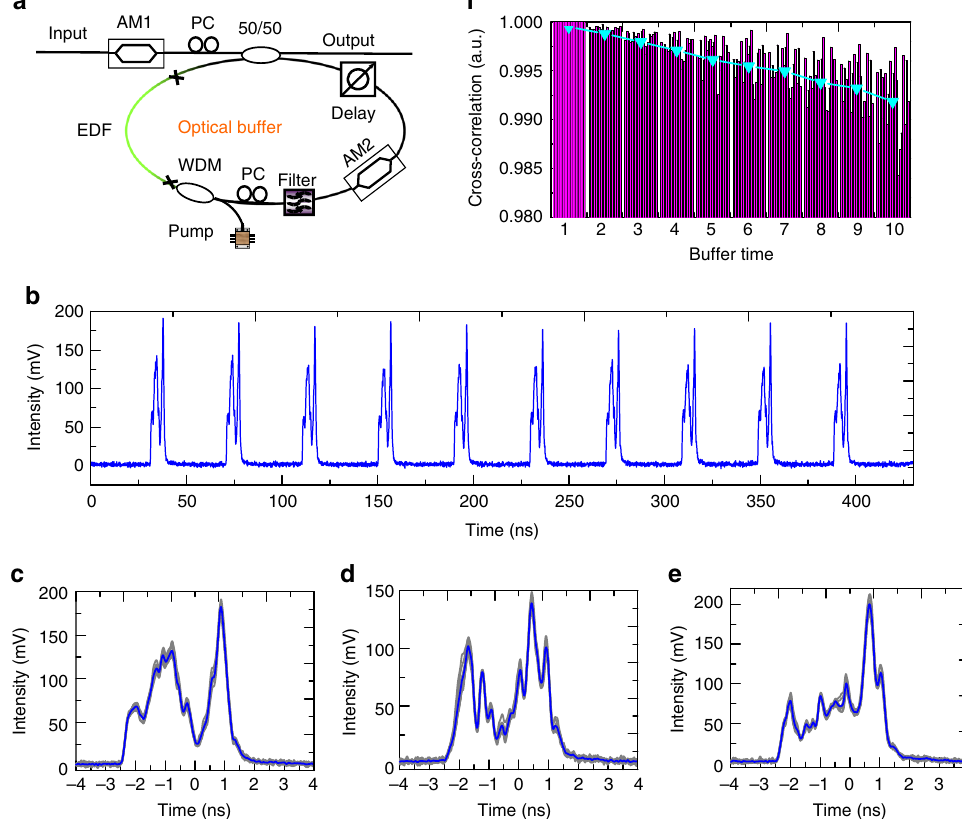
Fig. 3 Schematic representation and performance of the optical buffer. a Experimental setup of the optical buffer, which generates multiple high- fi delity replicas of arbitrary signals under test (SUTs) with fi ne-tunable period for subsequent stroboscopic signal acquisition. A SUT will be loaded into the buffer through the 50/50 coupler, and one replica will be generated when the SUT is circulated for each cavity round trip. b The output waveform when an arbitrary SUT is optically buffered for 10 times. c – e Three examples of buffering performance using distinct SUTs. Ten replicas are overlapping together ( grey curve ) and compared to their average ( blue ). f Quantitative characterization of the buffering performance using 20 different SUTs. Each column set in purple represents the cross-correlation coef fi cient between the replica after different times of buffering and the original waveform ( fi rst replica). The average values among 20 examples are shown by blue triangles , showing a fi delity loss of less than 1% after ten times of buffering. AM amplitude modulator, EDF erbium-doped fi bre, PC polarization controller, WDM wavelength-division